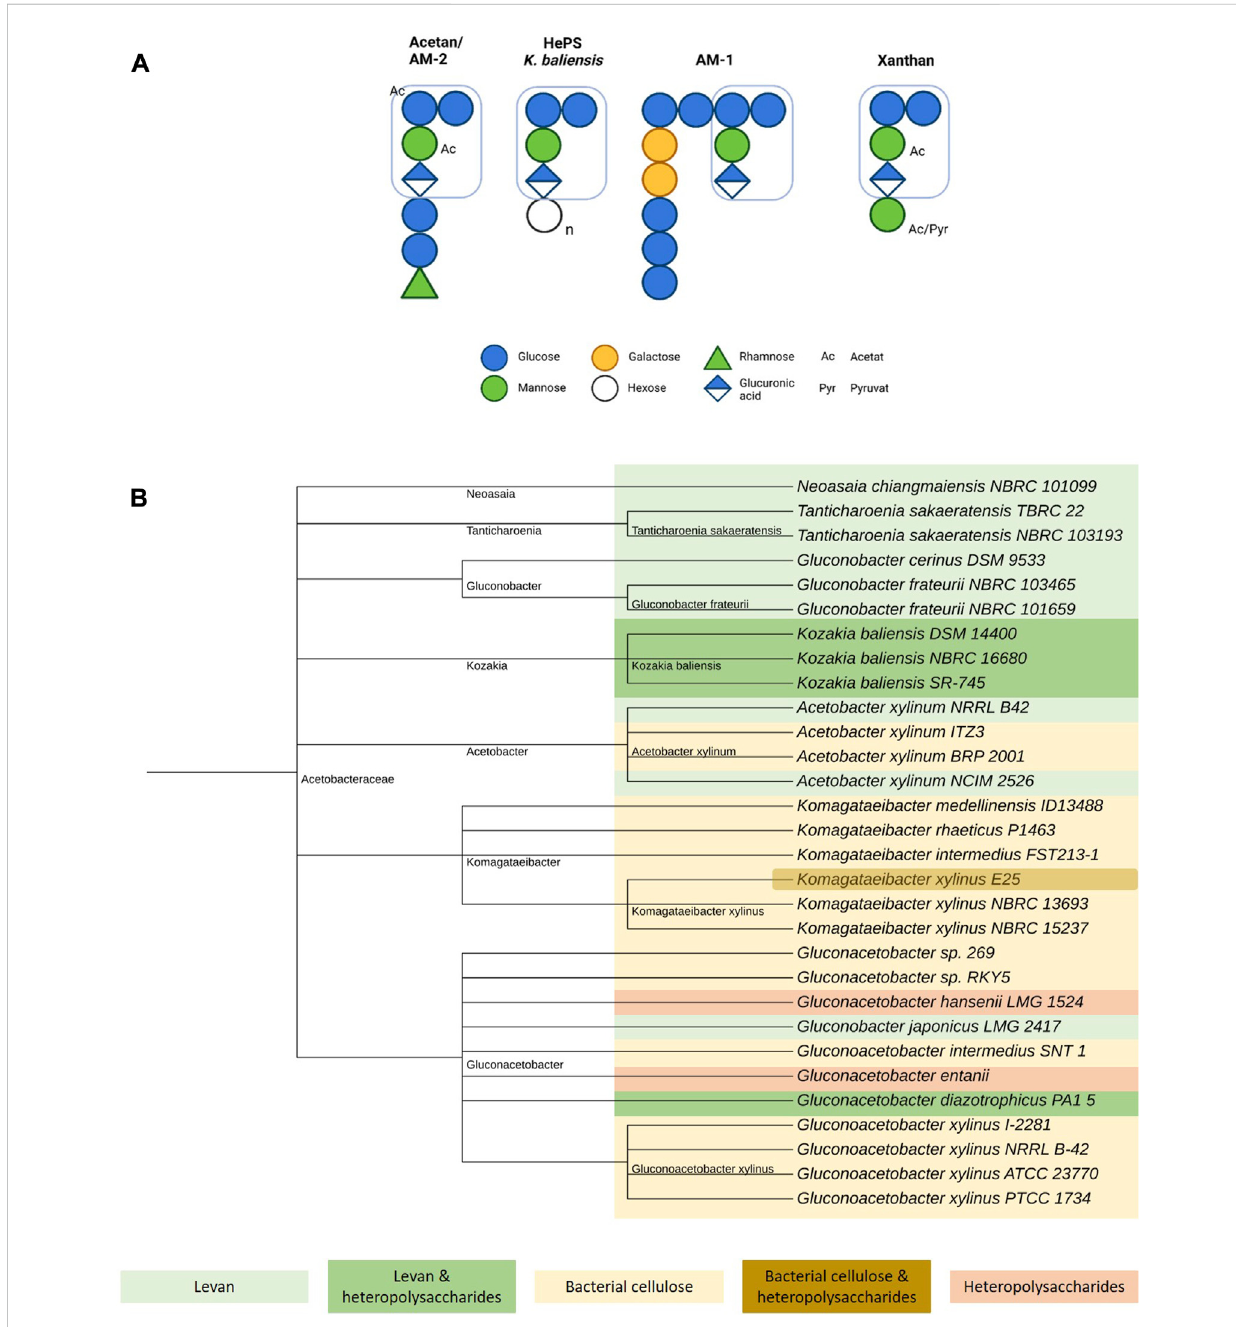
Overview of acetan-like heteropolysaccharide production in Acetobacteraceae . (A) Schematic comparison of selected acetan-like heteropolysaccharides produced by Acetobacteraceae including acetan, a yet unnamed heteropolysaccharide by Kozakia baliensis , AM-1, and